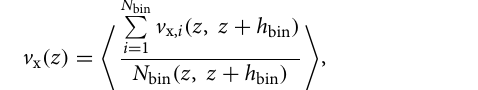
driving force ( f ex